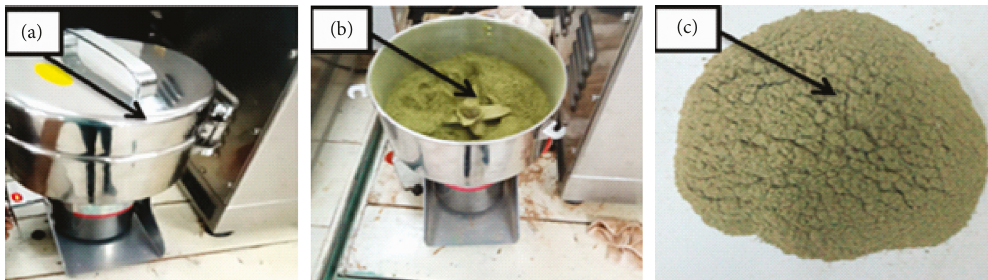
Figure 2: (a, b) Water hyacinth leaves in powder grinding and (c) powder form of the WH leaves.